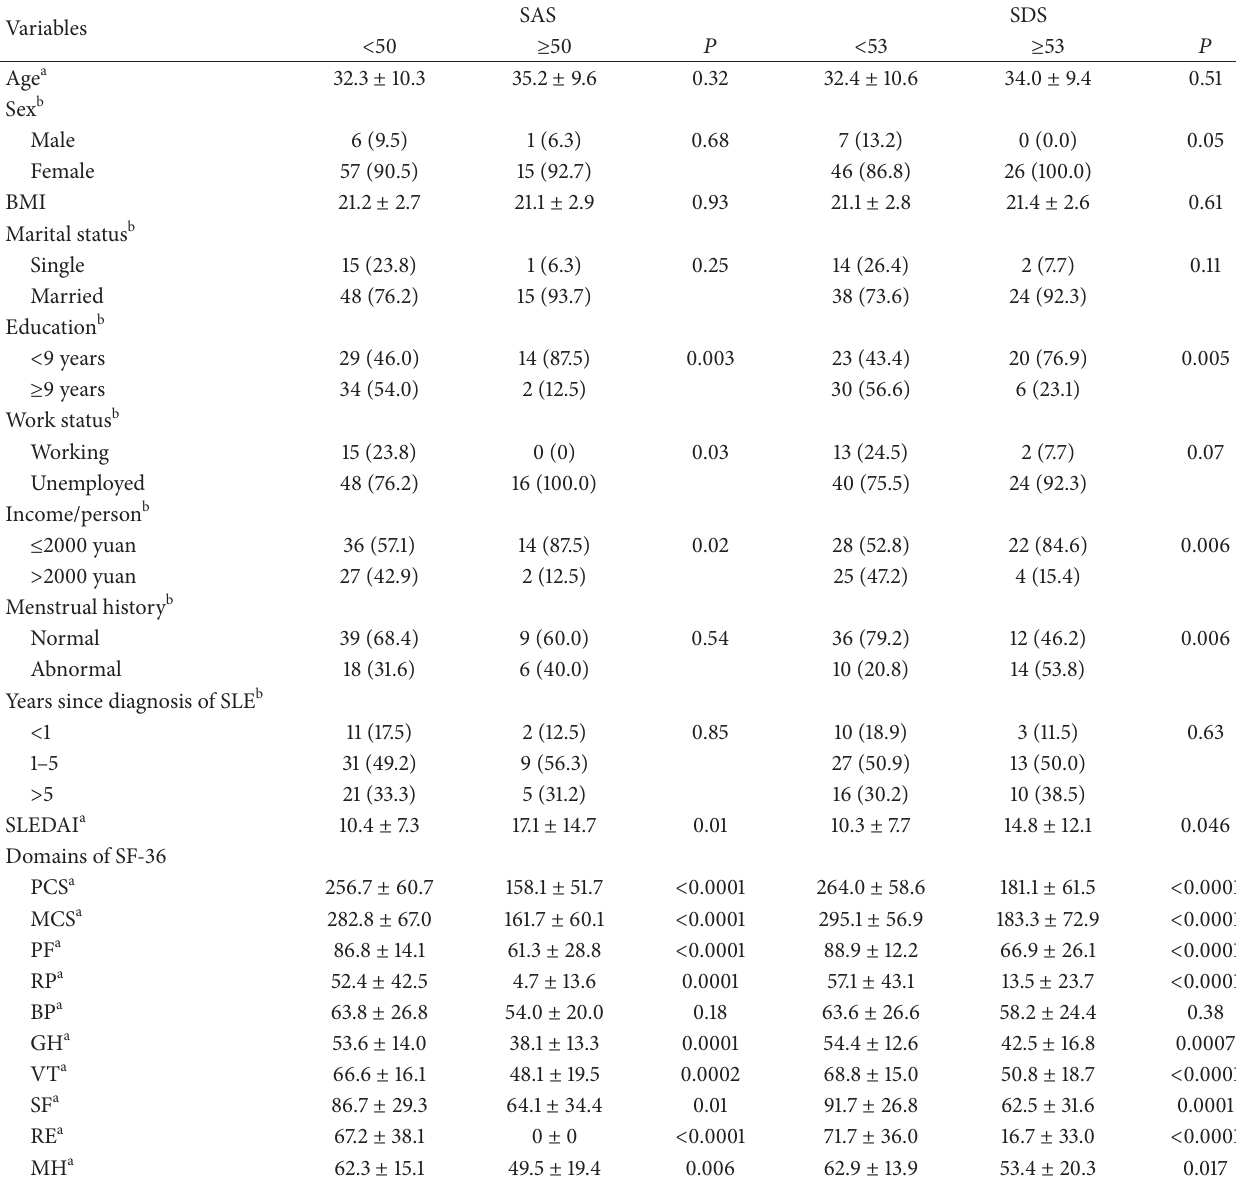
Table 3: Disease status and quality of life in the anxious and depressed subgroups.